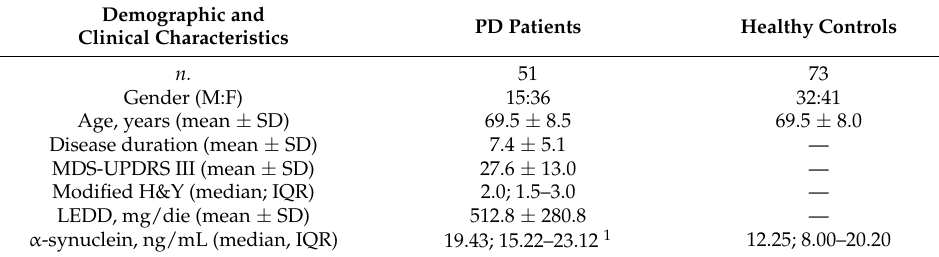
Table 1. Demographic and clinical characteristics of the individuals enrolled in the